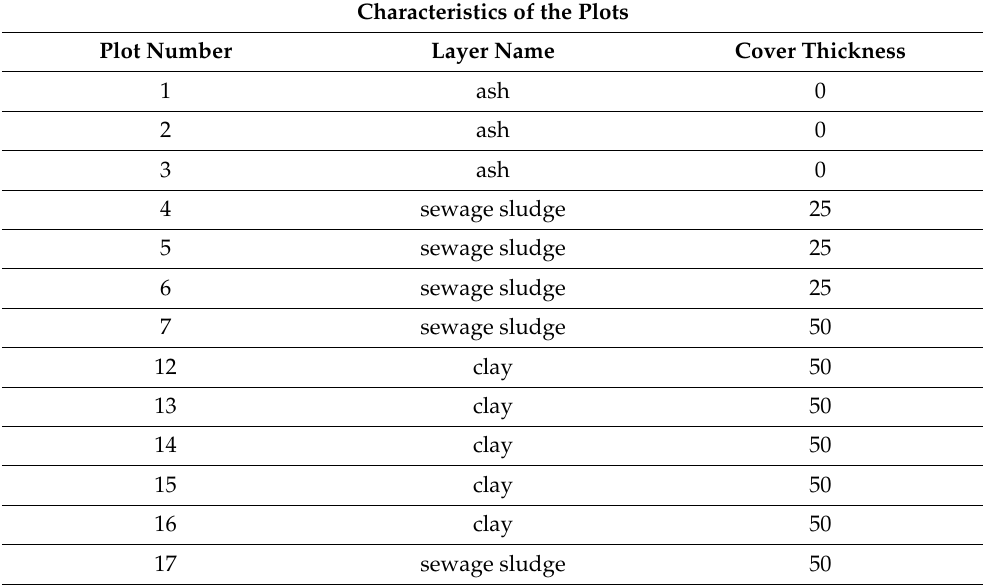
Table 1. Characteristics of the plots established within the experimental site. Characteristics of the Plots